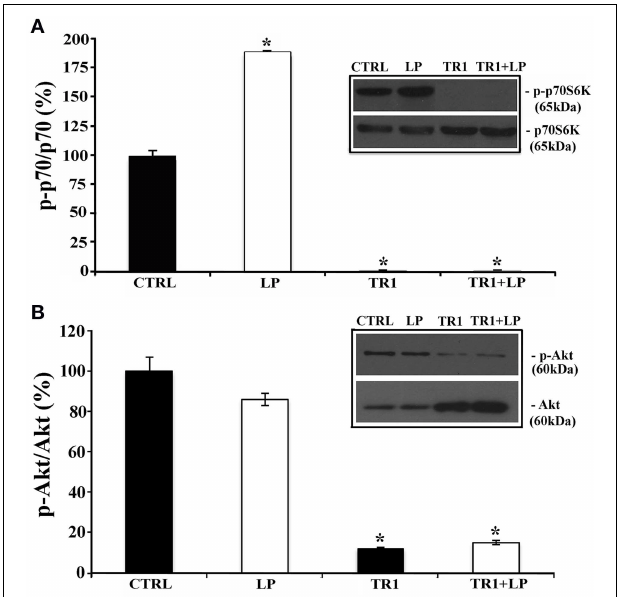
FIGURE 3 | Stimulation of 5-HT7R activates mTORC1 signaling. Cortical neurons were treated for 2h with the 5-HT7R selective agonist LP-211 (LP, 100nM), or the mTOR inhibitor torin 1 (TR1, 250nM), alone or in combination. (A) The bars show the level of p70S6K phosphorylation at Thr389 (means ± SEM, n = 6 ), expressed as percentage of values measured in the corresponding vehicle-treated cultures (CTRL, set to 100%). The level of p70S6K phosphorylation was measured by Western blot as intensity of p70S6K phosphorylated at Thr389 (p-p70S6K) normalized with that of total (phosphorylated and unphosphorylated) p70S6K in the same samples. The inset displays representative blots probed with antibodies against p-p70S6K and p70S6K; the molecular weights (kDa) are shown on the right. (B) The bars show the level of Akt phosphorylation at Ser473 (means ± SEM, n = 3 ), expressed as percentage of values measured in the corresponding vehicle-treated cultures (CTRL, set to 100%). The level of Akt phosphorylation was measured by Western blot as intensity of Akt phosphorylated at Ser473 (p-Akt) normalized with that of total Akt (Akt) in the same samples. The inset